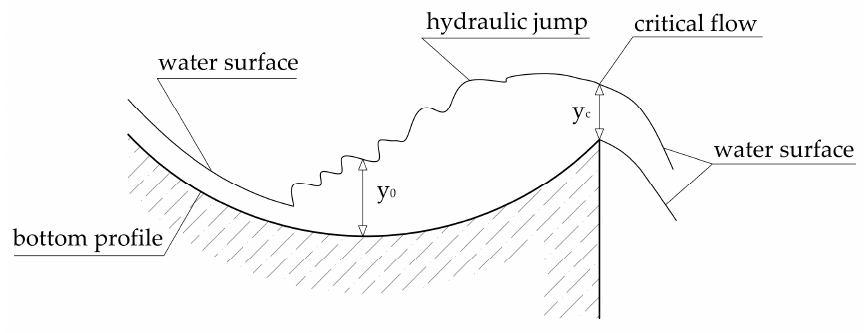
Figure 2. Flip bucket working as a weir for low flow rates.